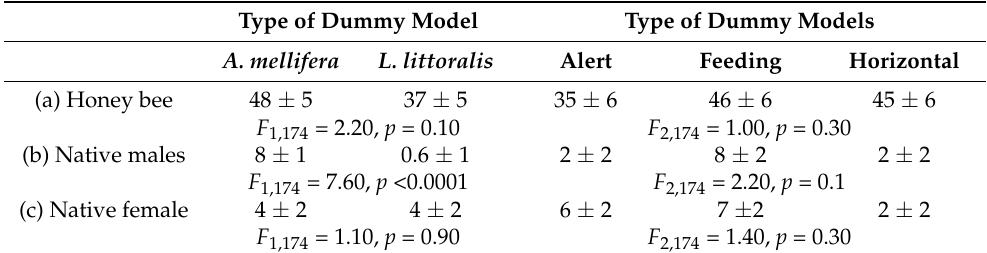
Table 1. Percentages of number of bees visiting flowers ( M ± SE ) of Opuntia huajuapensis with model bees of Apis mellifera and the native bee Lithurgus littoralis (male and female) and comparing between the three body position treatments of the dummy